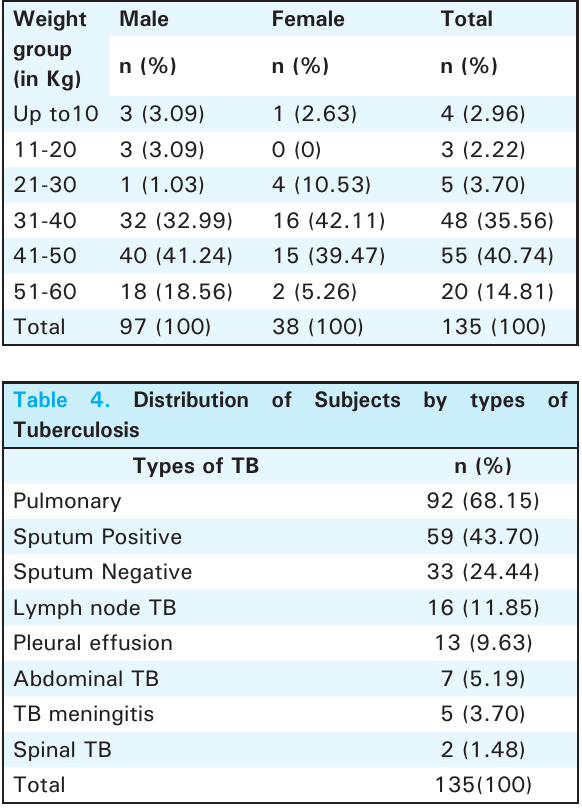
Table 3. Distribution of subjects by Weight group and sex.